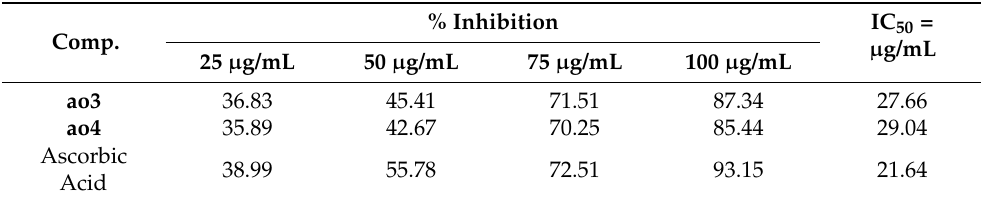
Table 55. Antioxidant activity of the compounds (ao3 – ao4 ). Table 56. In vitro antioxidant activity of the synthesized compounds ( ao5 – ao6 ) using the DPPH scavenging method.